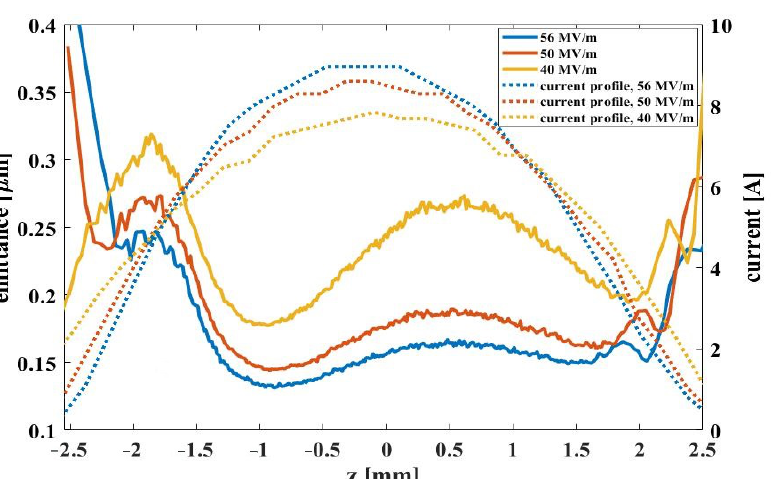
Figure 5. Slice emittance along the optimized bunches for three peak accelerating gradients at the cathode by the end of the injector. The current profiles are shown on the right axis. Blue: 56.3 MV/m; Red: 50 MV/m; Yellow: 40 MV/m. Solid: emittance; Dashed: current